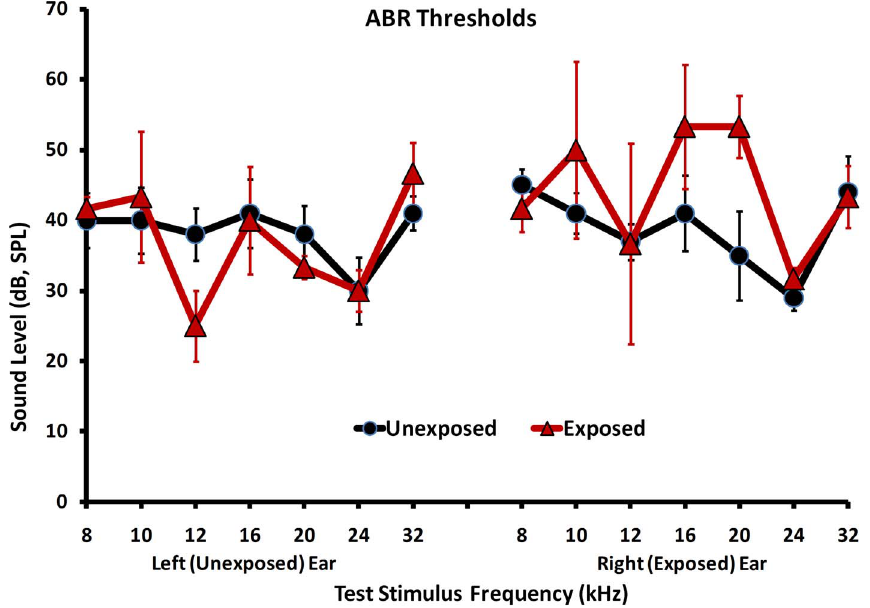
Figure 2. Pre-imaging, immediate post-psychophysics, auditory brainstem response (ABR) hearing thresholds for Exposed (see text) and Unexposed groups. Error bars indicate the standard error of the